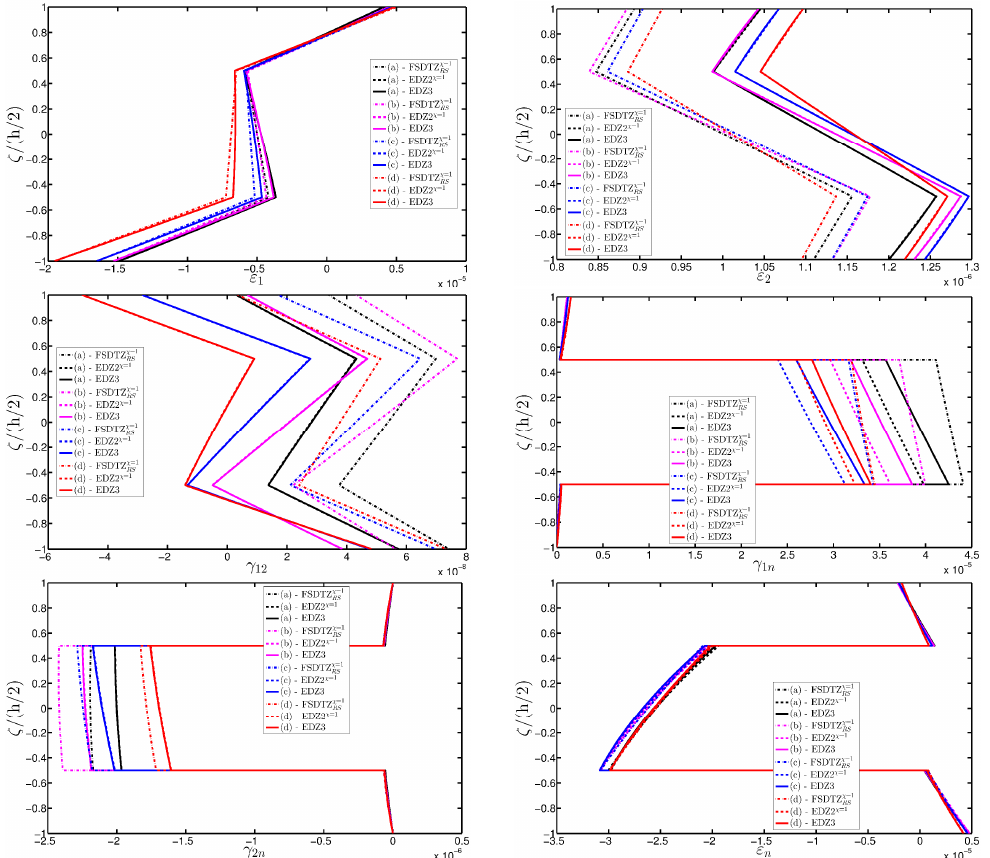
Figure 20. Evaluation of the central displacements profile [m] for the FCFC soft-core cylindrical surface varying the mechanical parameters of the damage (Ell-1): ( a ) Tangential displacement u 0 . The results are obtained by means of several HSDTs. ( b ) Vertical displacement u 0 3